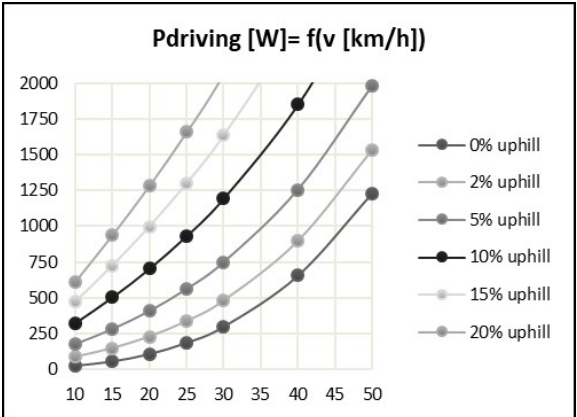
Figure 3. Driving power for speeds up to 50km/h and slopes up to